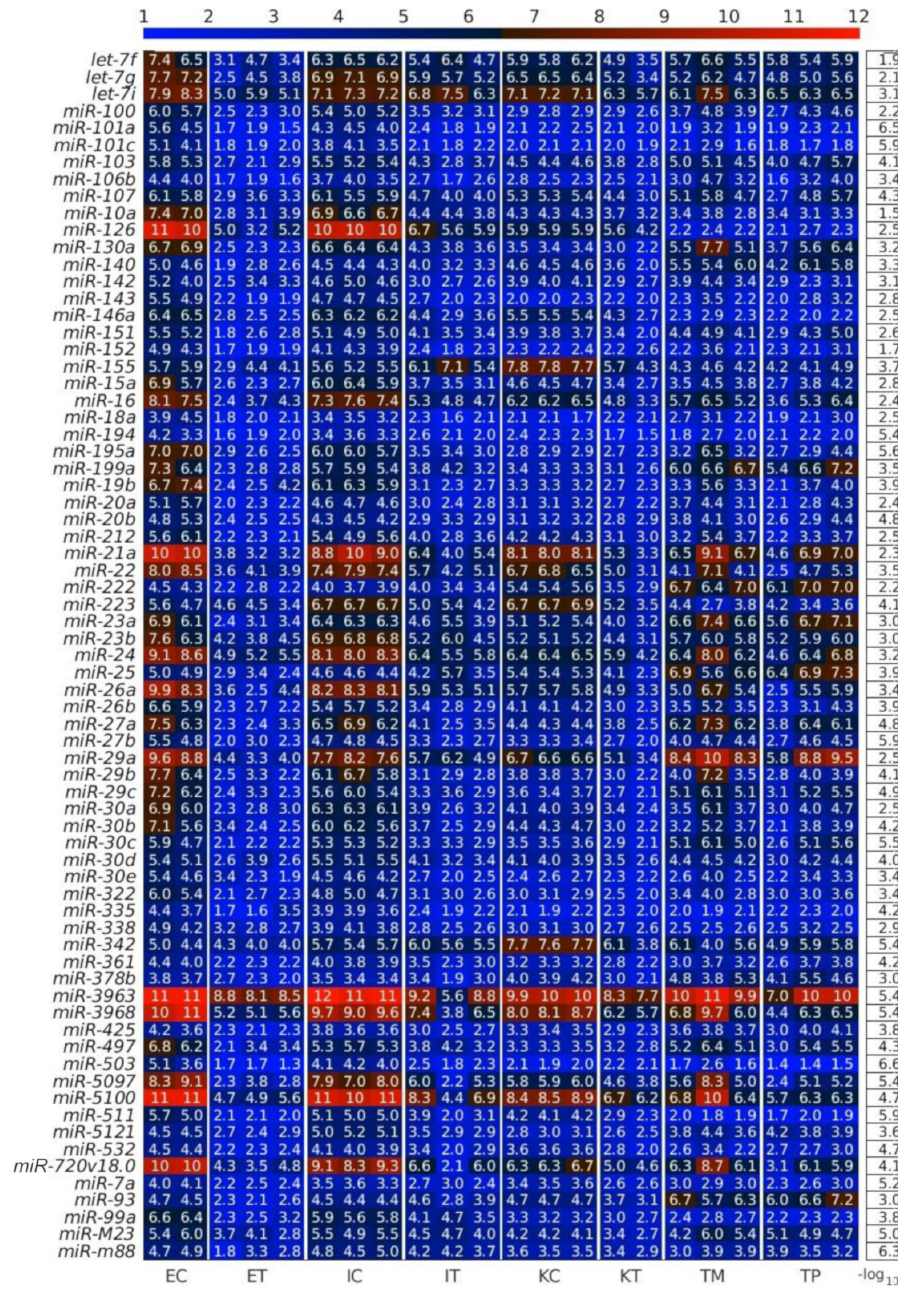
Figure 3. Downregulated miRNAs between the control and the tumor microenvironment (TME) cells. Heatmap of the expression of the differentially expressed miRNAs (DEMs) in lexicographic order of the miRNA names. The color bar codifies the miRNA expression in log 2 scale. Higher miRNA expression corresponds to redder color. The − log 10 ( p -value) of the DEMs are presented in a table to the right of the heatmap. The samples are denoted with E, I and K for endothelial, Ito and Kupffer cell, C and T for the control and the TME cells, and TP and TM for colorectal cancer (CRC) primary and liver metastasis cells,